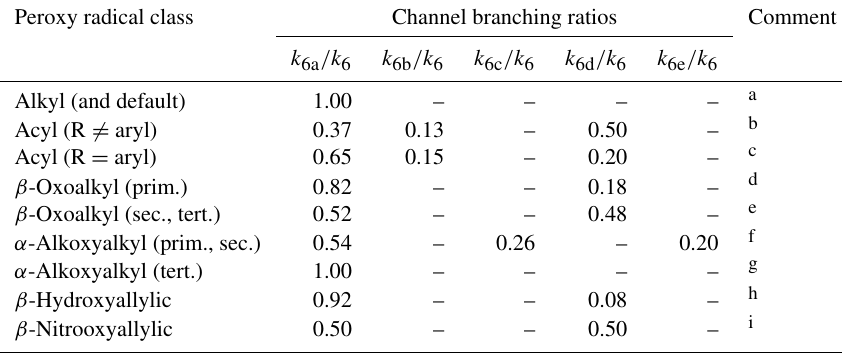
Table 8. Branching ratios assigned to reaction channels (R6a)–(R6e) for reactions of hydrocarbon and oxygenated peroxy radical classes with HO 2 at